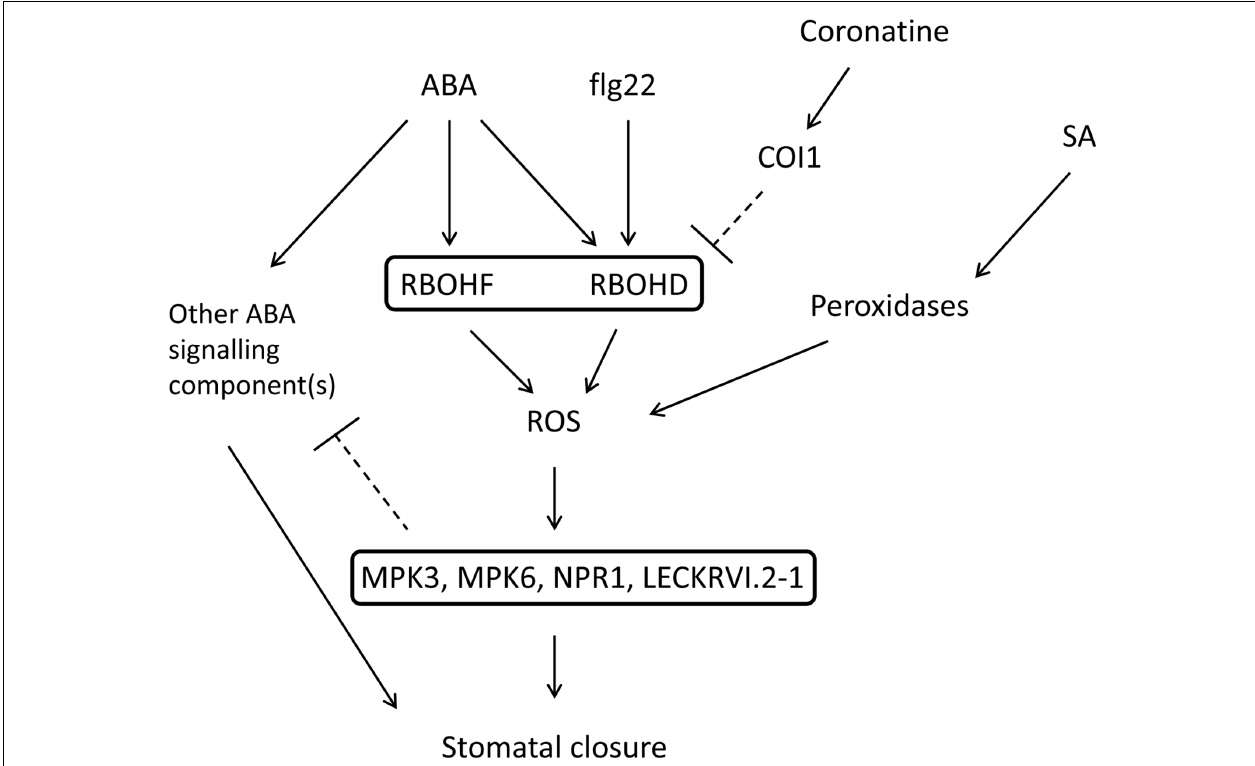
FIGURE 5 | Proposed model of ROS inhibition by coronatine in the context of ABA signaling. Coronatine inhibits stomatal closure induced by ABA and flg22 through inhibition of ROS synthesis by NADPH oxidases AtRBOHD and AtRBOHF. This toxin does not affect promotion of stomatal closure by SA, which induces ROS synthesis mediated by peroxidases. In atrbohd , mpk3 , mpk6 , npr1-3, and lecrkVI-2.1 mutants the sensitivity to ABA is not affected by coronatine or DPI. This might be due to negative regulation by ROS of other ABA signaling components, which would be upregulated in these mutants. Thus in these mutants ABA is able to close stomata in the absence of ROS